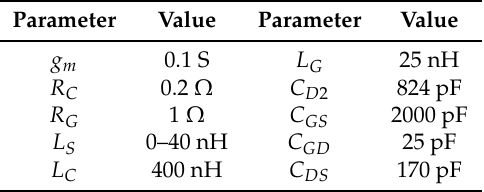
Table 1. Parameters for the theocratical